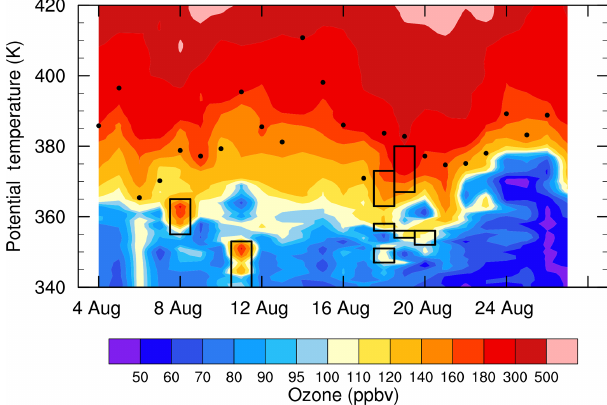
Figure 1. Daily variations of ozone mixing ratios (OMRs) between 340 and 420K during 4–27 August 2013 from balloon measure- ments launched in Lhasa. The black dots represent the lapse-rate tropopause. High tropospheric ozone is shown by the black rectan-